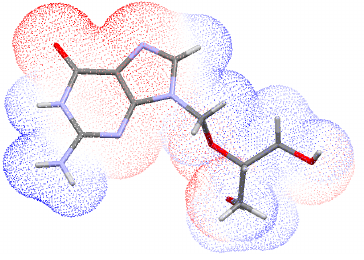
Figure 3. Electrostatic map of form I, mapped on the molecular vdW surface. Double bonds are omitted only for visualization purposes.